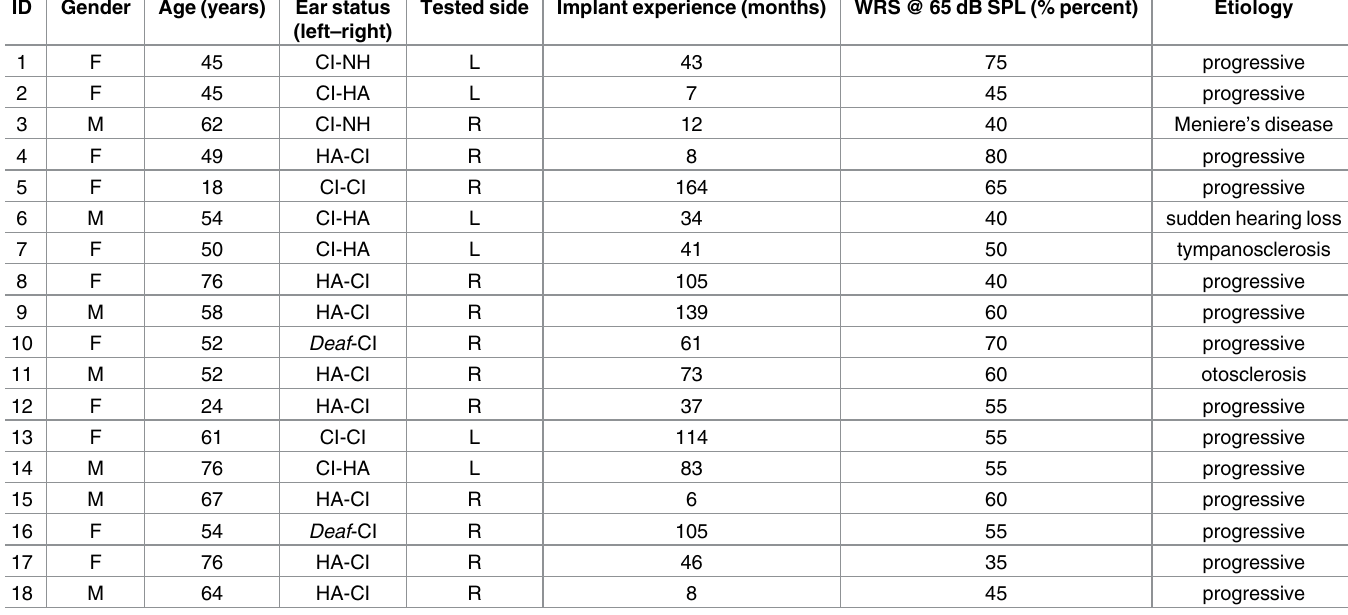
F = female; M = male; CI = cochlear implant; HA = hearing aid; NH = normal hearing; WRS = word recognition score with CI; Deaf = profoundly deaf; L = left; R =